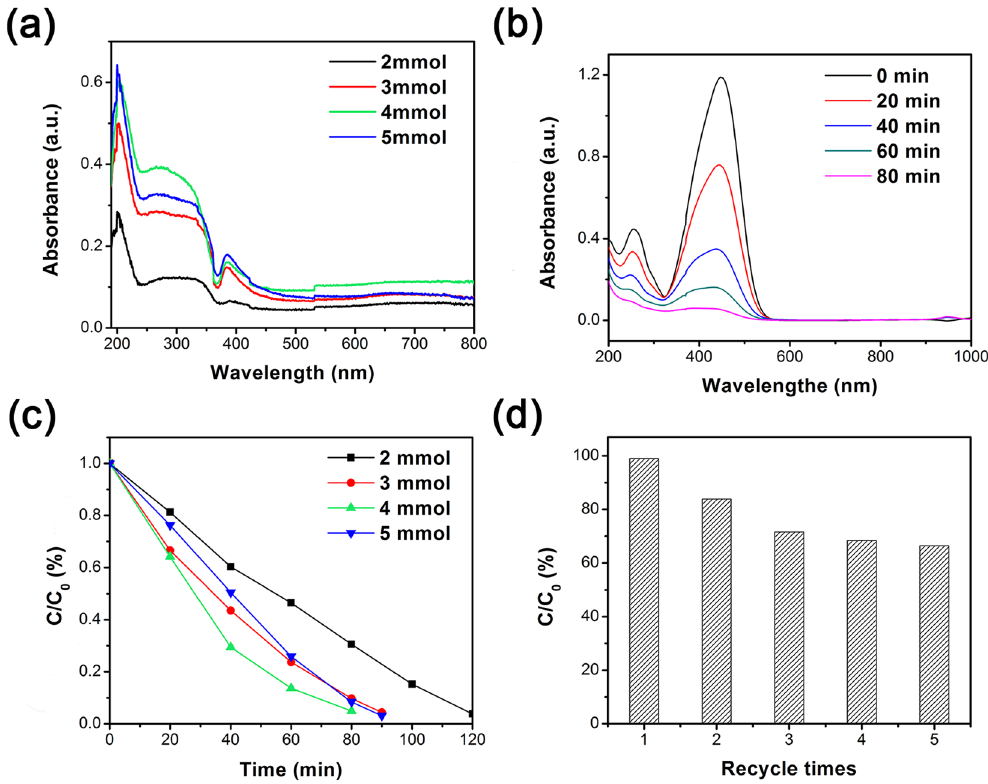
Figure 7. ( a ) UV-visible spectra of NZZN-2 mmol, NZZN-3 mmol, NZZN-4 mmol and NZZN-5 mmol samples; and ( b ) photocatalytic degradation efficiency of MO aqueous solution containing different samples: NZZN-2 mmol, NZZN-3 mmol, NZZN-4 mmol and NZZN-5 mmol as a photosensitizer. ( c ) UV-vis absorption spectra of MO solution with as-obtained NZZN-4 mmol sample. ( d ) Five cycles for photodegradation of MO for NZZN-4 mmol